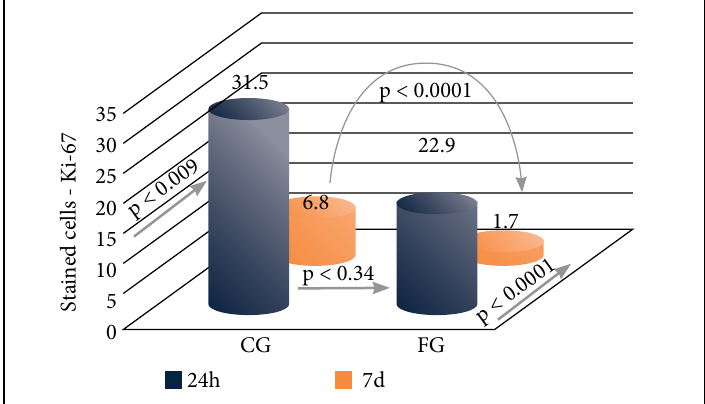
Figure 5 - Liver regeneration by Ki-67-stained hepatocytes. Statistical comparisons between the control (CG) and 5-fluorouracil (FG) groups at 24 h and 7 days. Blue: 24-h subgroups; Red: 7-day subgroups. Mann–Whitney and Student’s t tests (p)